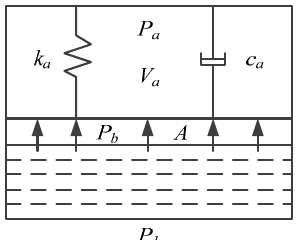
Figure 9. Gas spring-damping model.